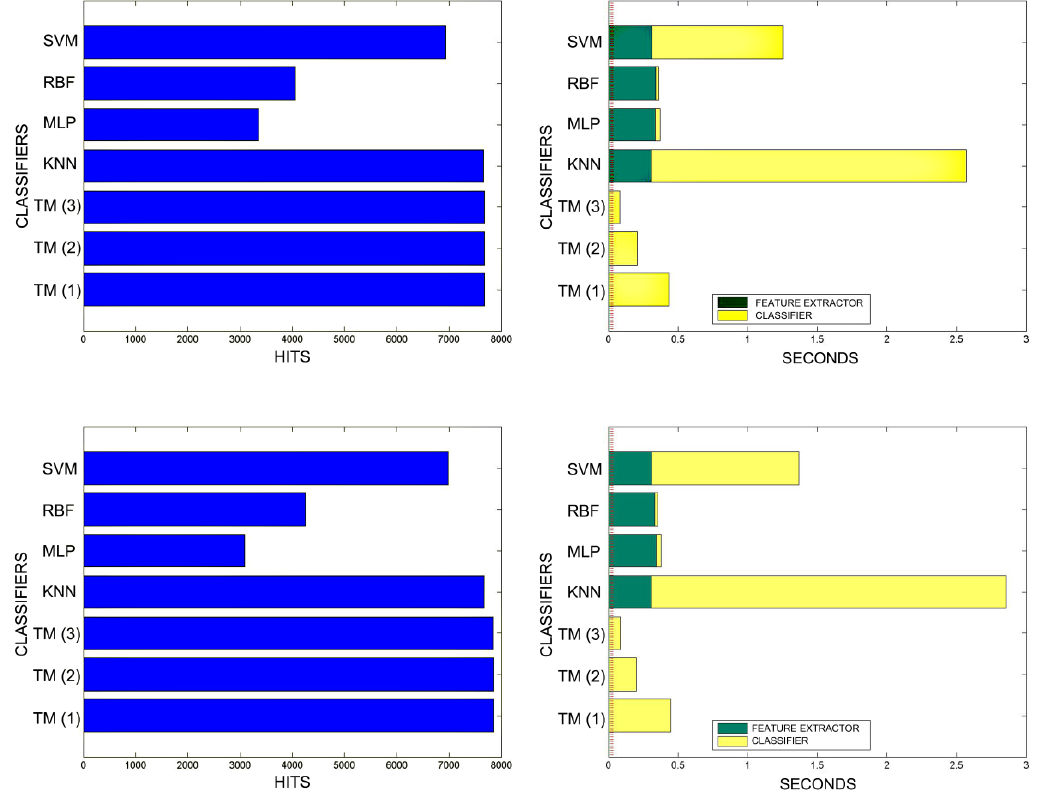
represent 60% and 70% of the total training samples.